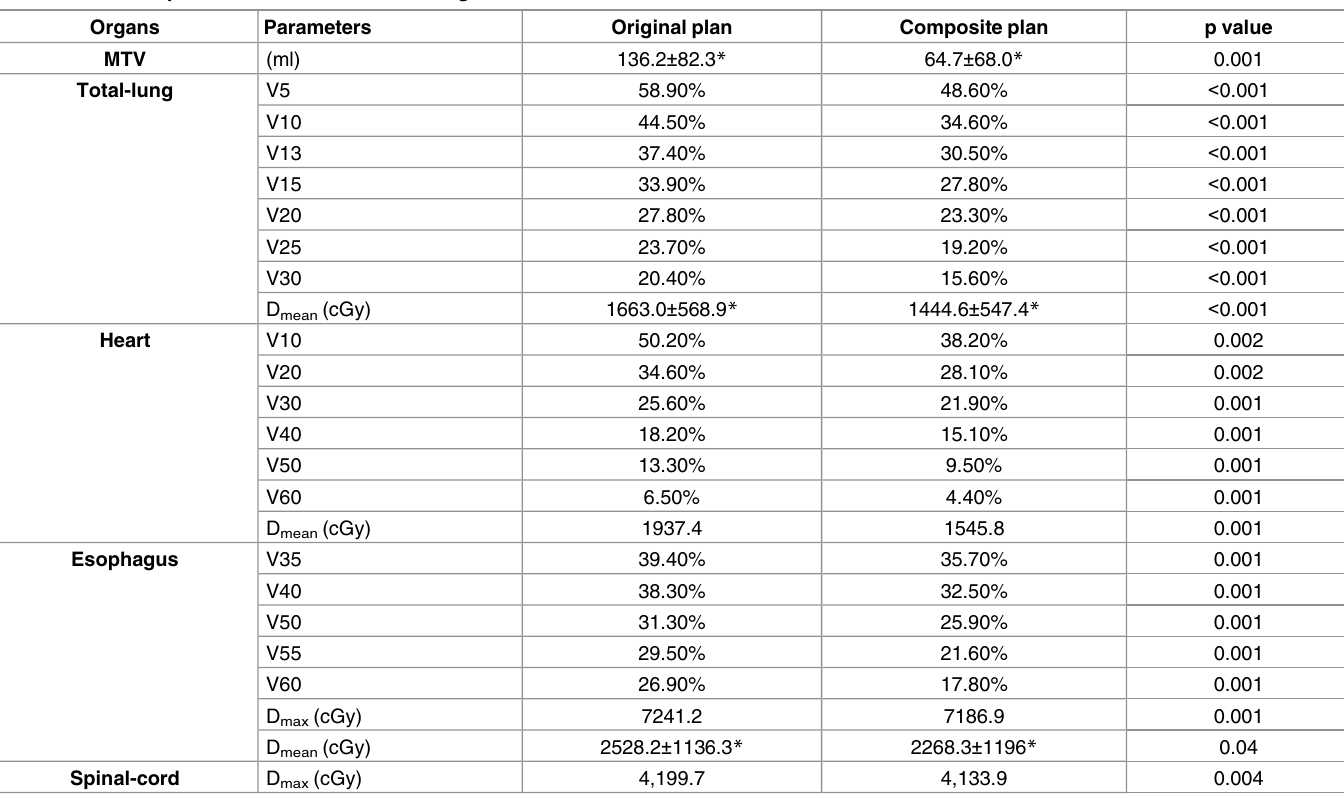
Table 2. MTV and parameters of DVH for all the organs at risk.